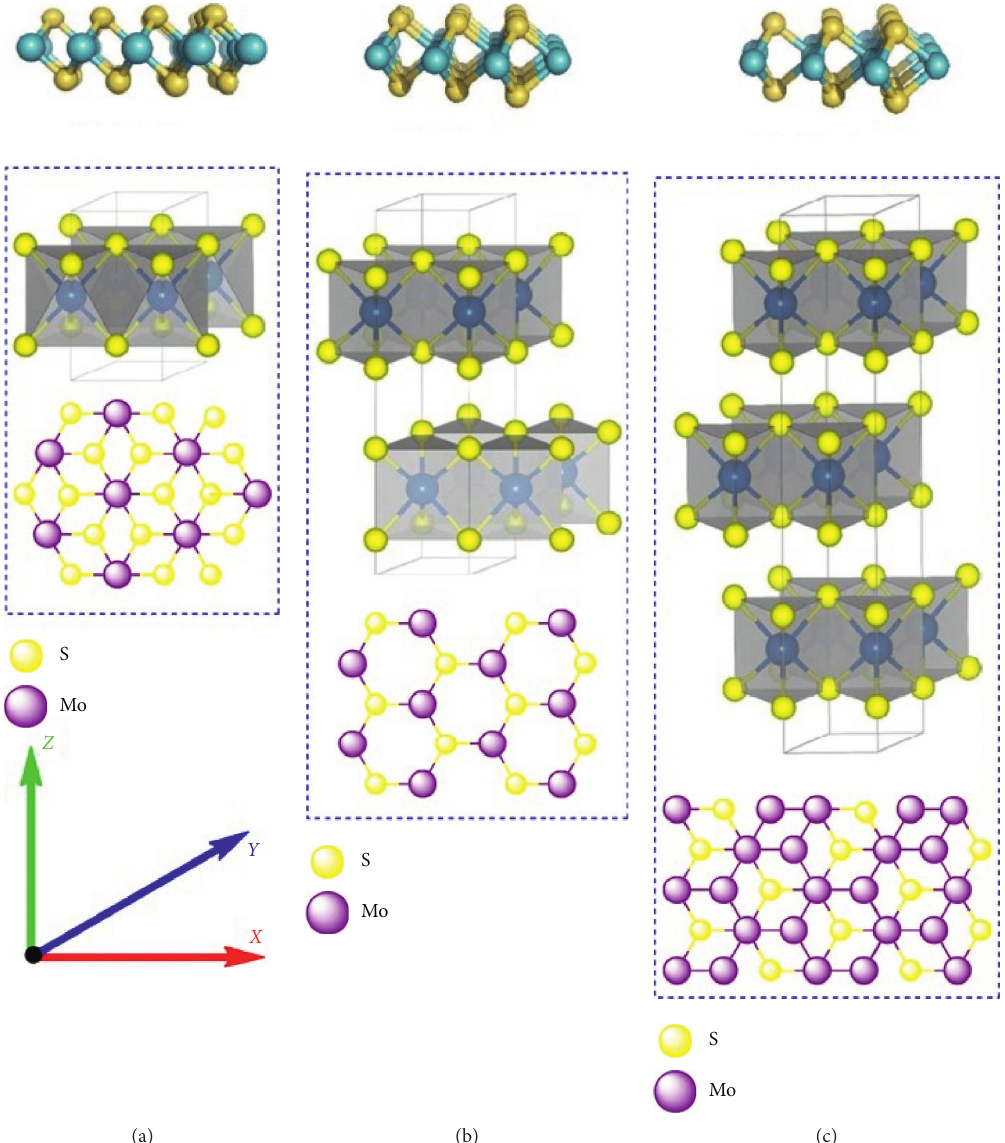
Figure 1: Illustration of the (a) octahedral IT, (b) trigonal prismatic 2H, and (c) trigonal prismatic 3R-crystal structures of MoS